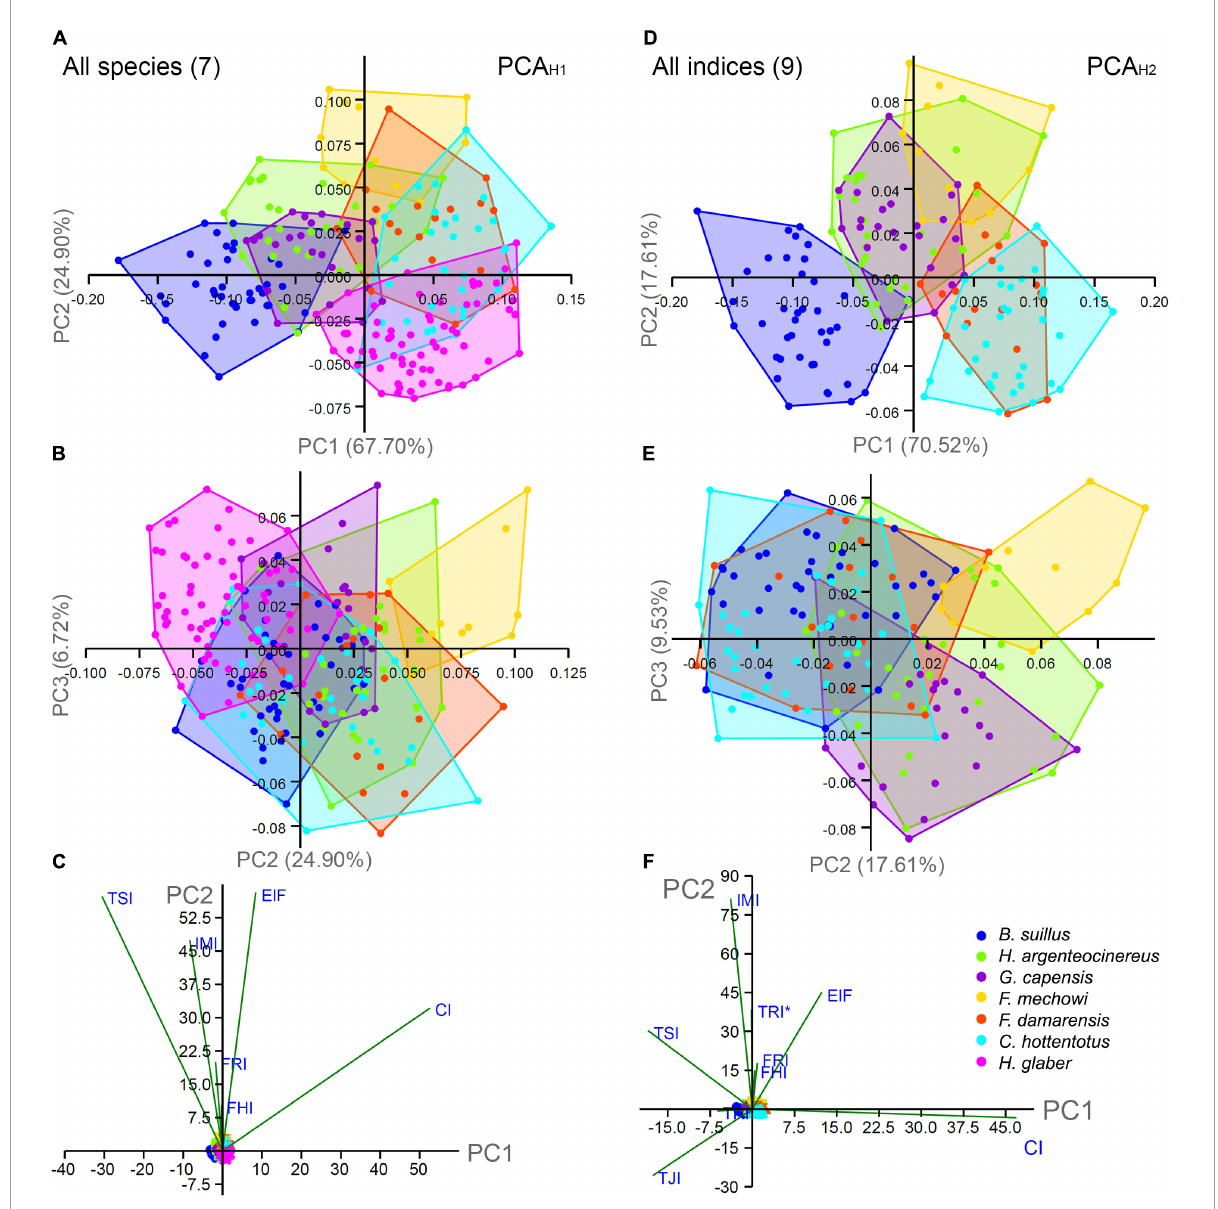
FIGURE6 Ordination analysis for the morpho-functional indices of the hindlimb including all species (PCA H1 ) and all indices (PCA H2 ). (A) Principal components (PC1 and PC2) of PCA H1 . (B) PC2 and PC3. (C) Biplots for PC1 and PC2. (D) PC1 and PC2 of PCA H2 . (E) PC2 and PC3. (F) Biplots for PC1 and